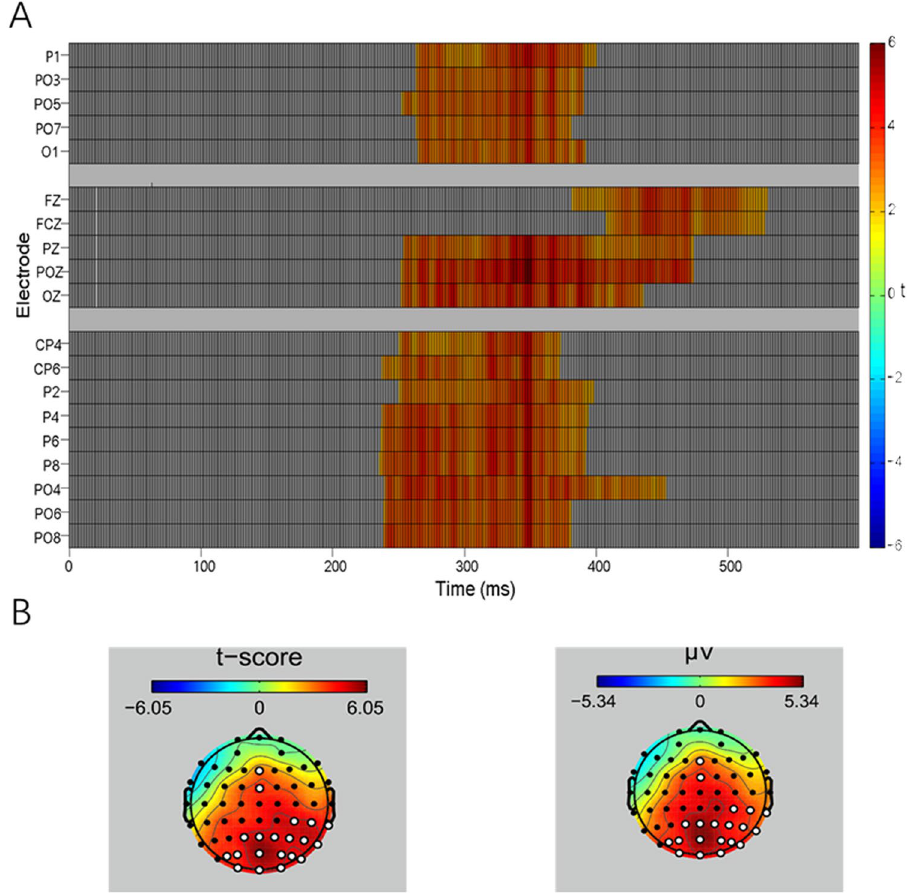
Figure 2. Point-wise cluster test of the integration effect with MUET. ( A ) Significant clusters in time points and electrodes (only significantly different electrodes are displayed) that occurred in the time window of approximately 236–530 ms. ( B ) Distributions of significant electrodes in the scalp topography (white